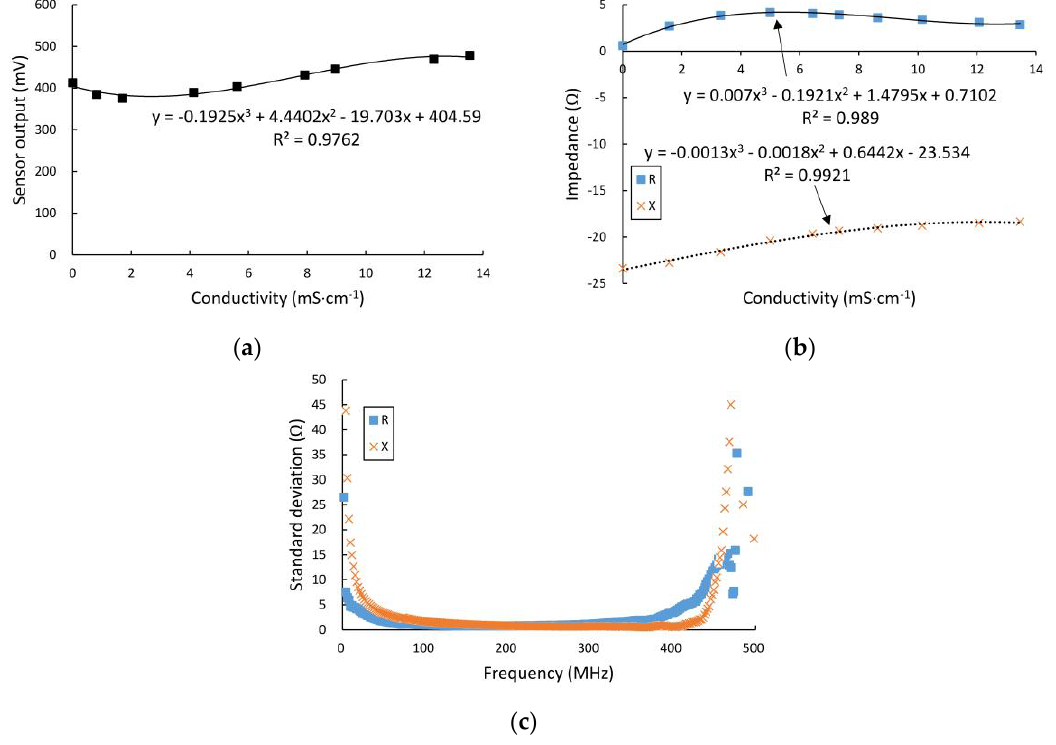
Figure 9. Results of experiments on conductivity variation effects. ( a ) The relationship between conductivity and the differential output voltage from detection circuit at frequency of 100 MHz; ( b ) the relationship between conductivity and output impedance from the VNA at a frequency of 100 MHz; and ( c ) standard deviations at various frequencies ranging from 300 kHz to 300 MHz.